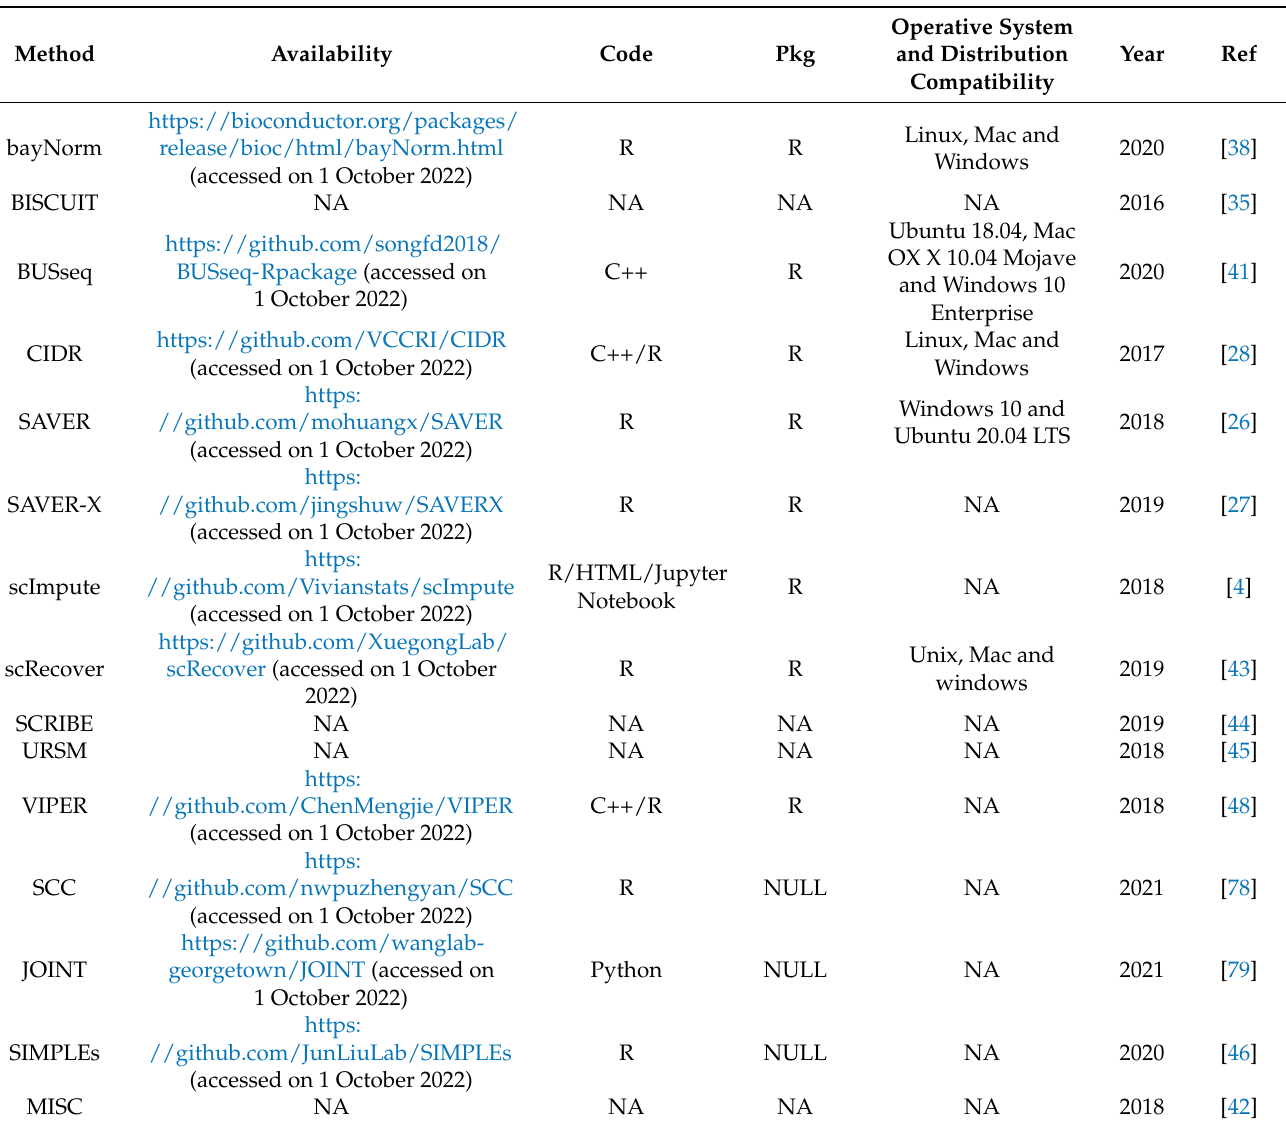
Table 2. The availability links, programming language, whether a package is available, year of presentation, operative system, distribution compatibility and reference of the representative methods based on